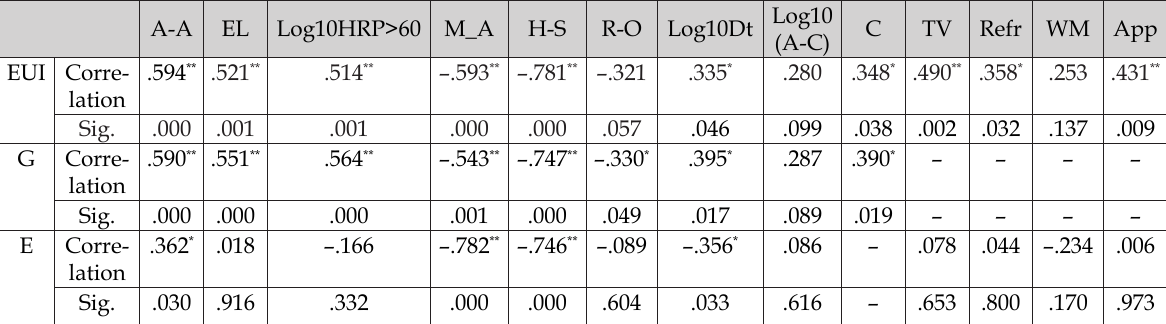
Table 5. Bivariate correlations between energy consumption and households, housing variables, density